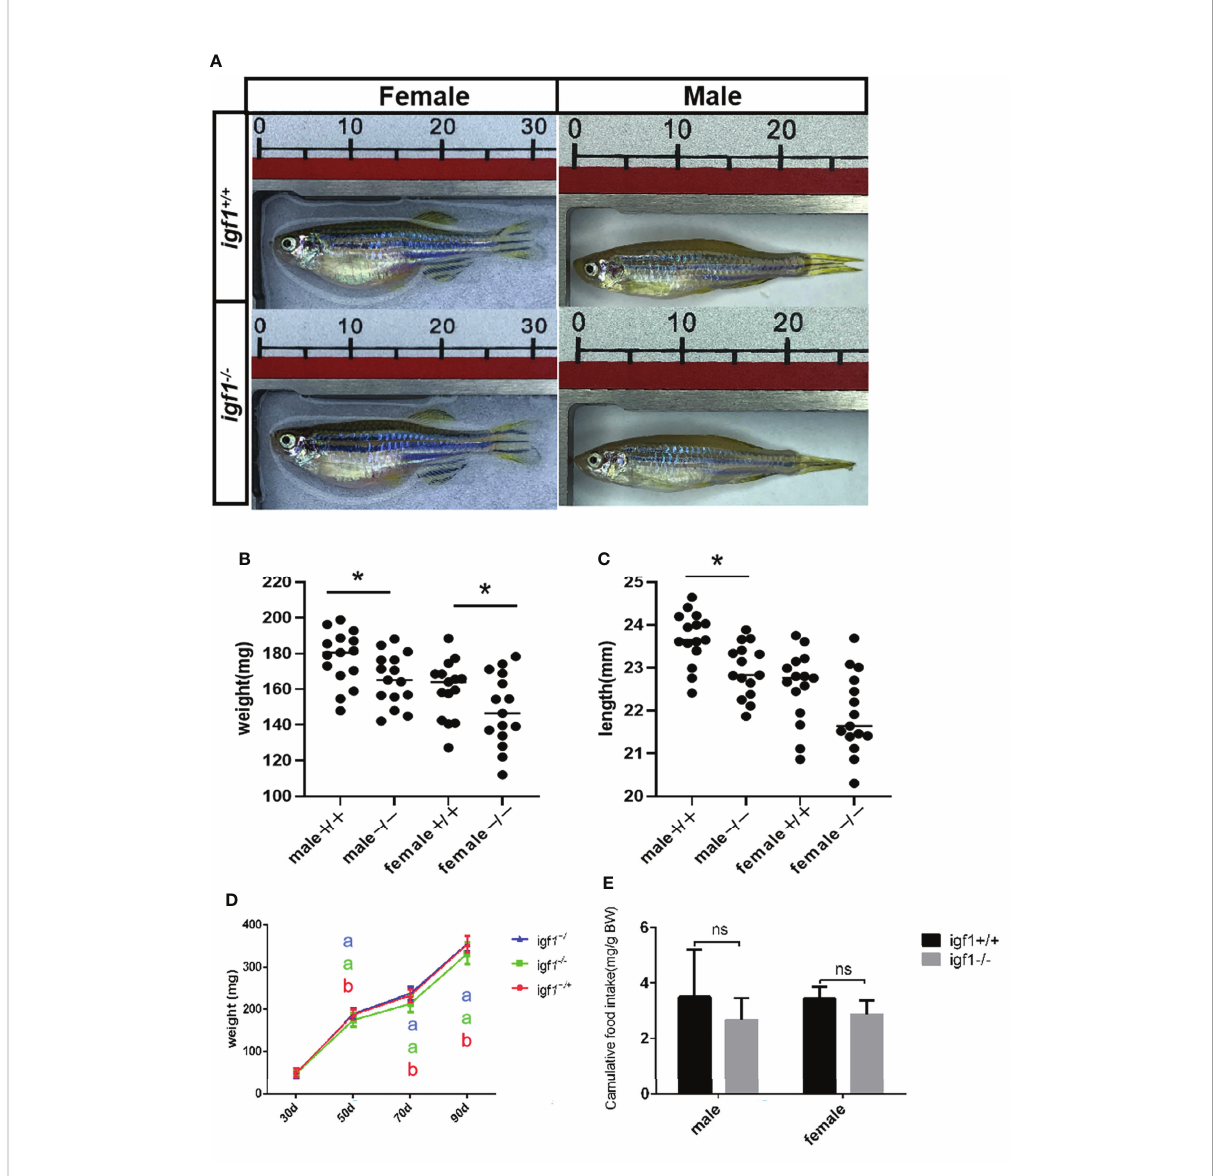
FIGURE 4 General growth performance traits of igf1 -de fi cient fi sh. (A) Appearance of igf1 -de fi cient fi sh and their control wild-type fi sh at 90 dpf (n=15/ group). (B, C) Body weight of the fi sh at the 90-dpf stage. Three times of independent growth analysis were carried out and showed similar results. * P < 0.05. (D) Growth curves of wild type, heterozygous and igf1 -de fi cient zebra fi sh during the growth statge. (E) The food intake data was showed in the chart. 10 animals were weighted for each experiment and three biological repeats were carried out and statistical analysis was performed using a t test (ns, p>0.05, n=3). The letters a and b in the charts represent signi fi cant differences between which labeled with different